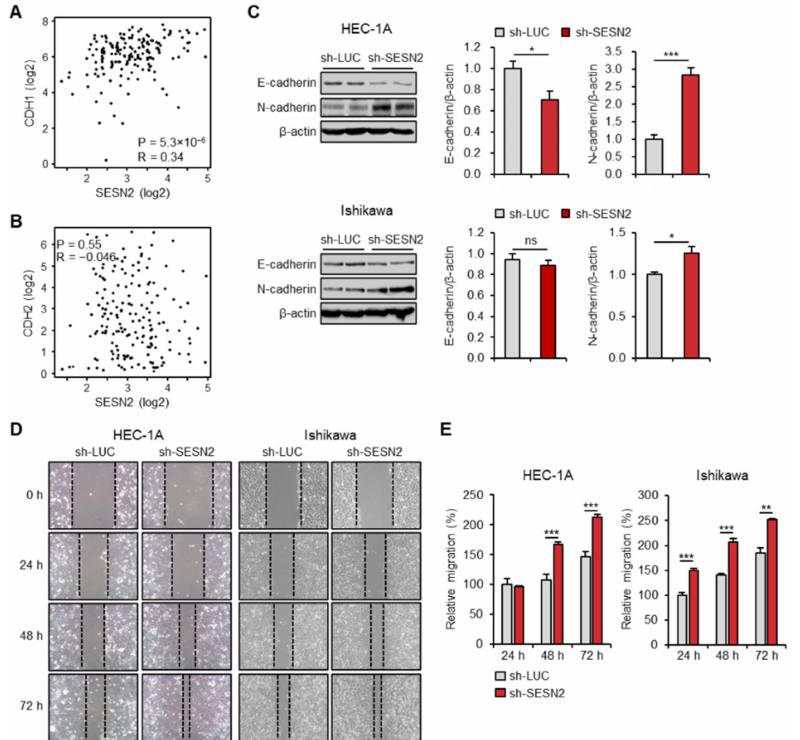
Figure 4. Knockdownof SESN2 promotesEMTandmigrationinendometrialcancercells. ( A , B )Correlation between expression of SESN2 and EMT marker genes CDH1 (coded E-cadherin) ( A ) and CDH2 (coded N-cadherin) ( B ) in endometrial cancer, analyzed using the GEPIA database. The correlation coe ffi cients were calculated using Spearman’s test. ( C ) Immunoblotting analysis in HEC-1A and Ishikawa cells infected with sh- LUC or sh- SESN2 lentivirus. Cell lysates were immunoblotted with